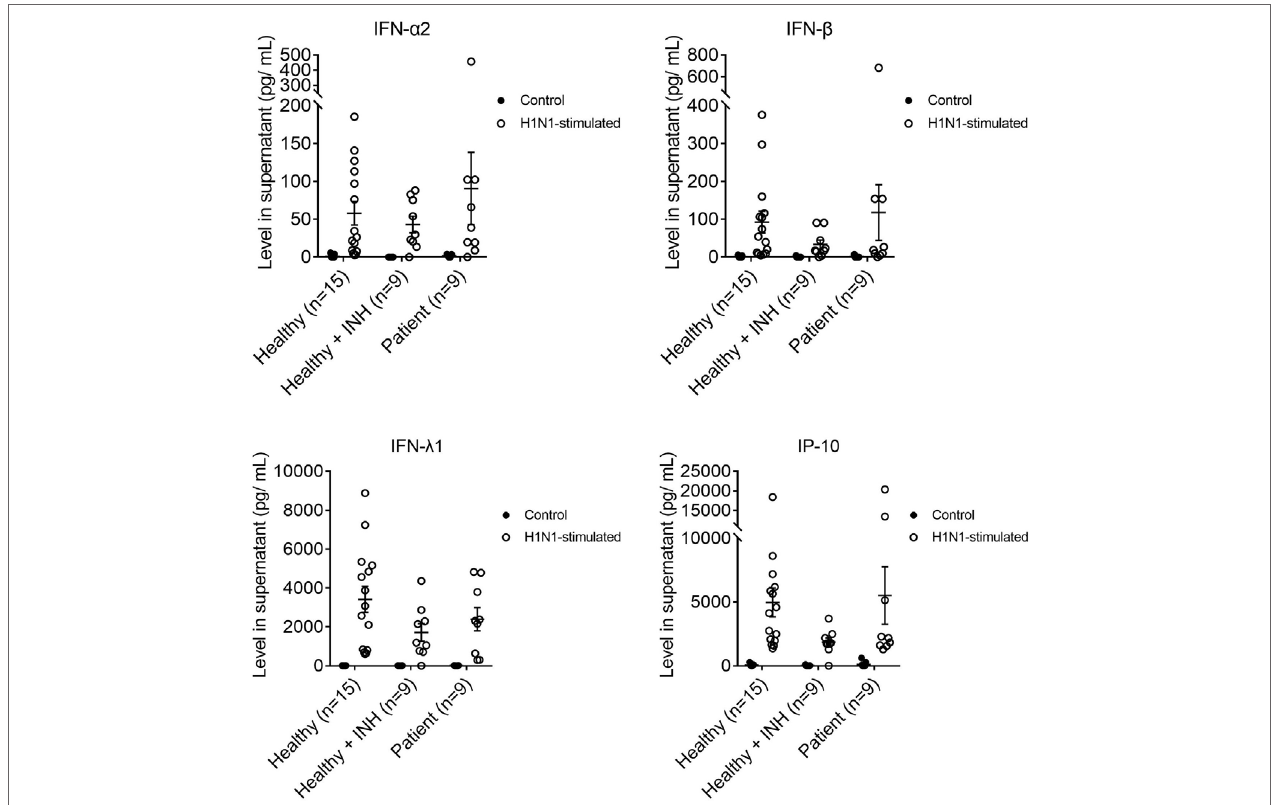
FigUre 4 | IFN- α 2, IFN- β , IFN- λ 1, and interferon gamma-induced protein 10 productions in MoDCs from healthy controls ( n = 15), Bruton’s tyrosine kinase (BTK)-inhibited MoDCs from healthy controls ( n = 9), and MoDCs from X-linked agammaglobulinemia (XLA) patients ( n = 9) upon H1N1 stimulation. MoDCs were stimulated with H1N1 at multiplicity of infection of 1 for 24 h. Open symbols represent MoDCs stimulated with H1N1; filled symbols represent MoDCs that were mock-stimulated with RPMI. Controls of healthy controls, BTK-inhibited healthy controls, and XLA patients were subsets of controls in Figure 3 . Healthy + INH, BTK-inhibited MoDCs from healthy controls. Data represented as mean ±